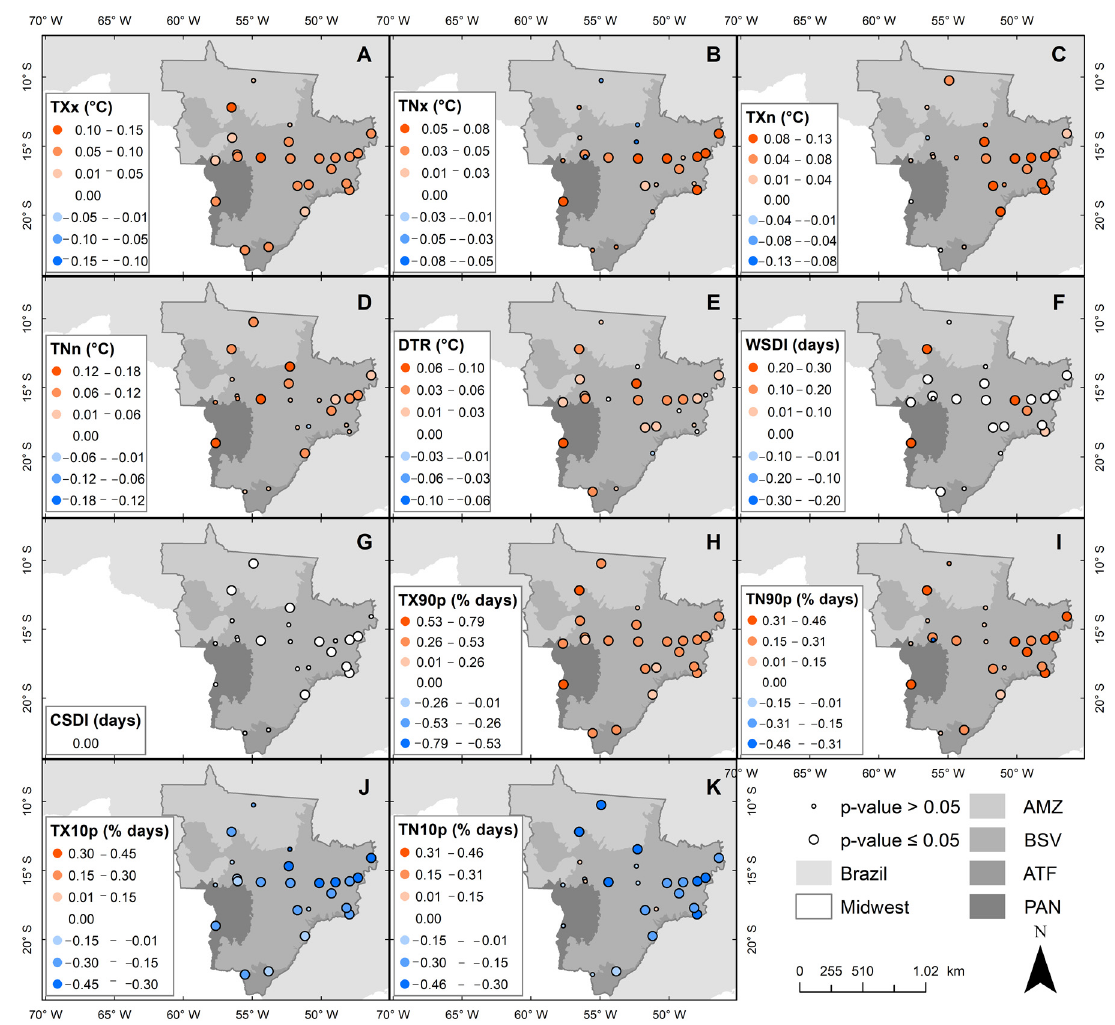
Figure 5. Spatial distribution of trends for Warmest Day (TXx) ( A ), Warmest Night (TNx) ( B ), Coldest Day (TXn) ( C ), Coldest Night (TNn) ( D ), Diurnal Temperature Range (DTR) ( E ), Warm spell duration (WSDI) ( F ), Cold spell duration (CSDI) ( G ), Warm Days (TX90p) ( H ), Warm Nights (TN90p) ( I ), Cool Days (TX10p) ( J ), and Cool Nights (TN10p) ( K ) in the Brazilian Midwest from 1979 to 2019. The bluish-colored dots refer to the range of positive trends, while the reddish-colored ones refer to that of negative trends.